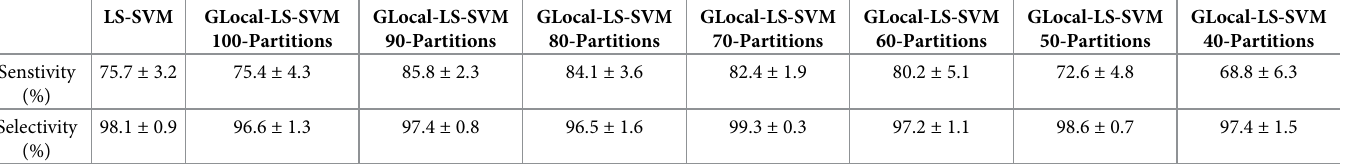
Table 1. Comparing the classification performance of the global LS-SVM model to the GLocal-LS-SVM models (40-100